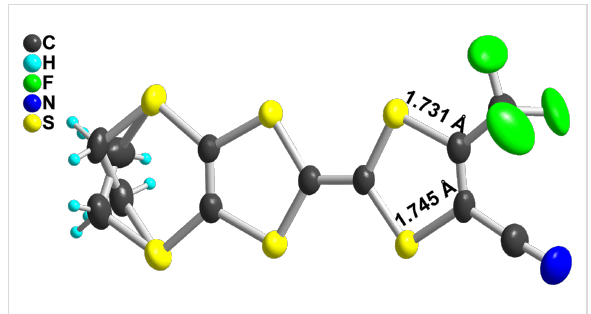
Figure 3: View of the 2ac molecule. Thermal ellipsoids are shown at the 50% probability level.